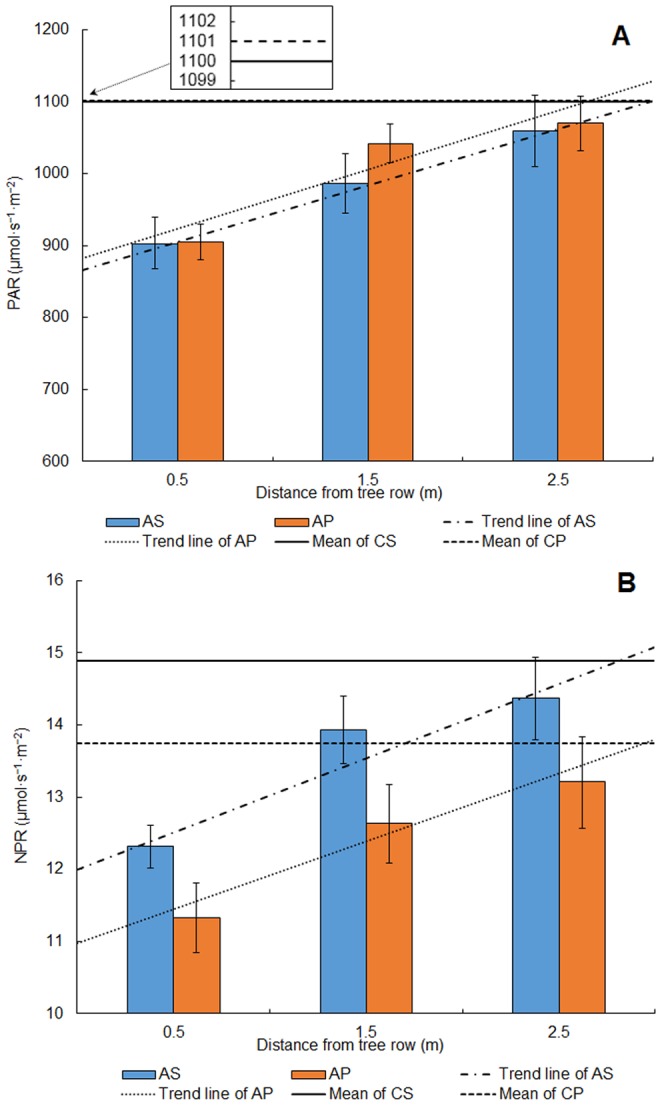
Daily mean of photosynthetically active radiation (PAR) and net photosynthetic rate (NPR) for the intercropping systems and its control (A. PAR and B. NPR).Vertical lines indicate confidence interval at 95% level.